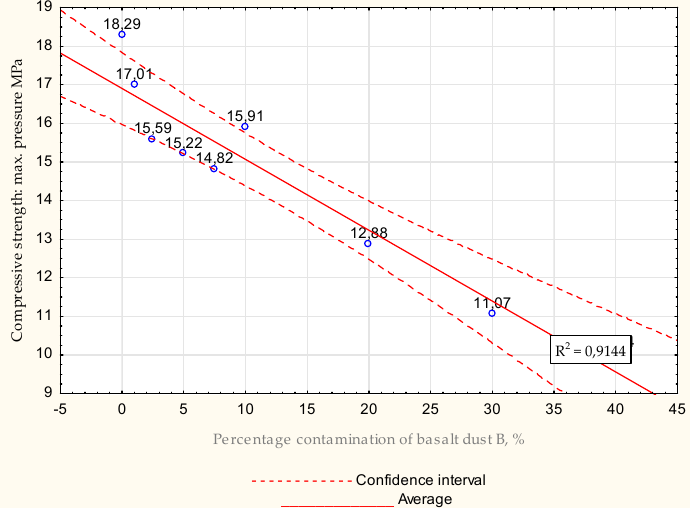
Figure 38. Average values obtained during compressive strength tests after 28 days for water − mix ratio = 0.7, max. pressure.